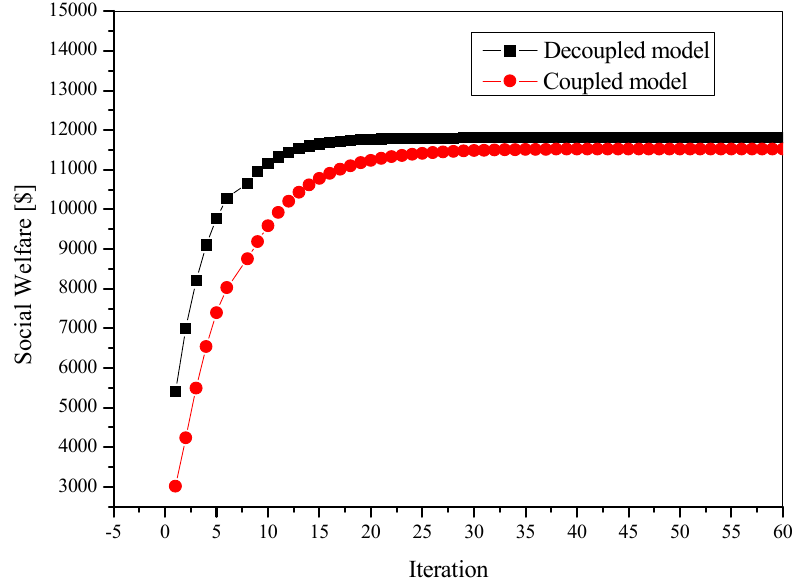
-5 Figure 6. Comparison of the convergences of the Figure 6. Comparison of the convergences of the models.